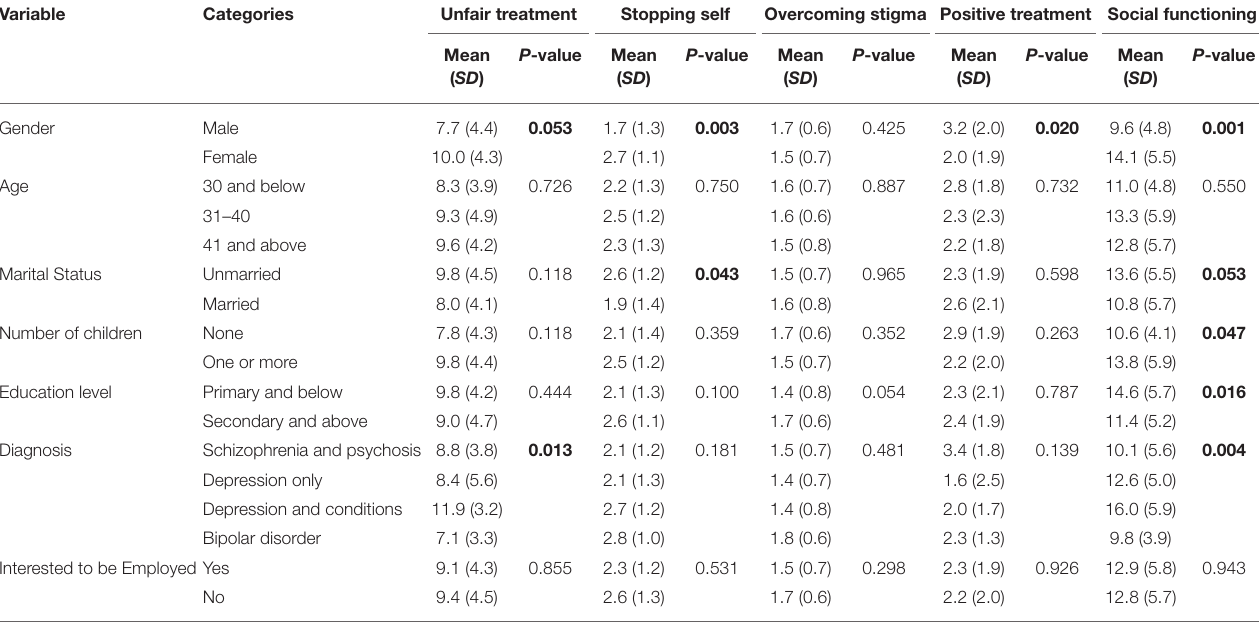
TABLE 4 | Association between socio-demographic characteristics and unfair treatment, stopping self, overcoming stigma, positive treatment, and social functioning.